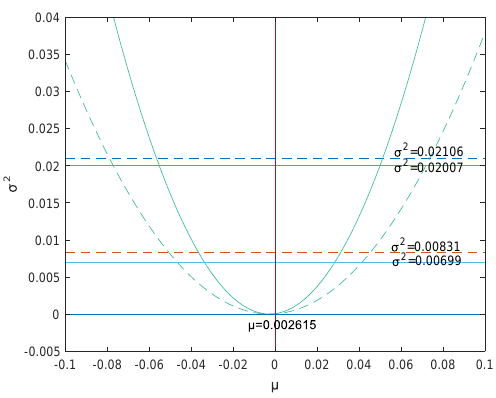
Figure 8. The contrast of two methods.